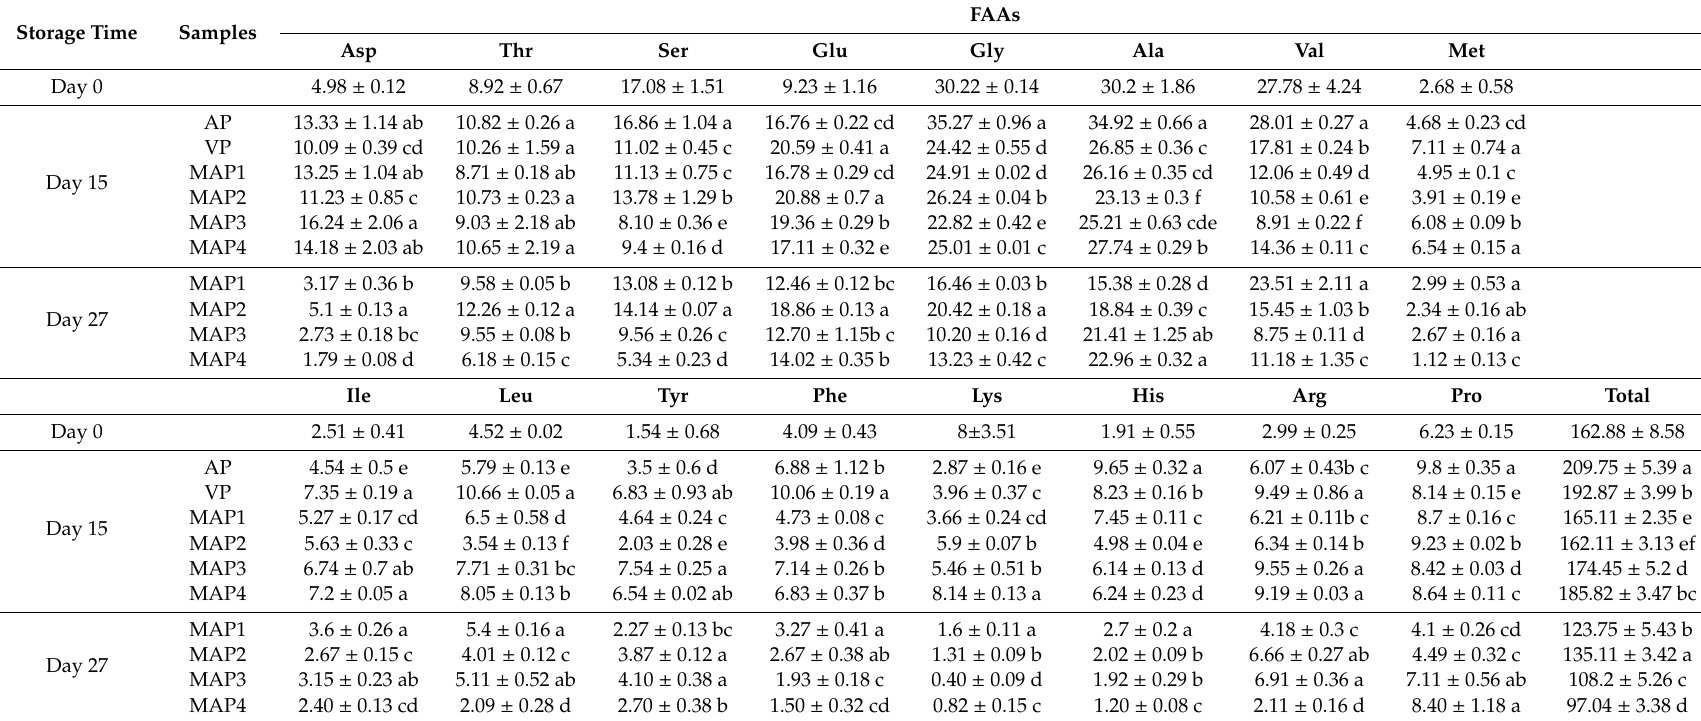
Table 1. Changes in FAA content (mg / 100g) of turbot with di ff erent treatments during storage